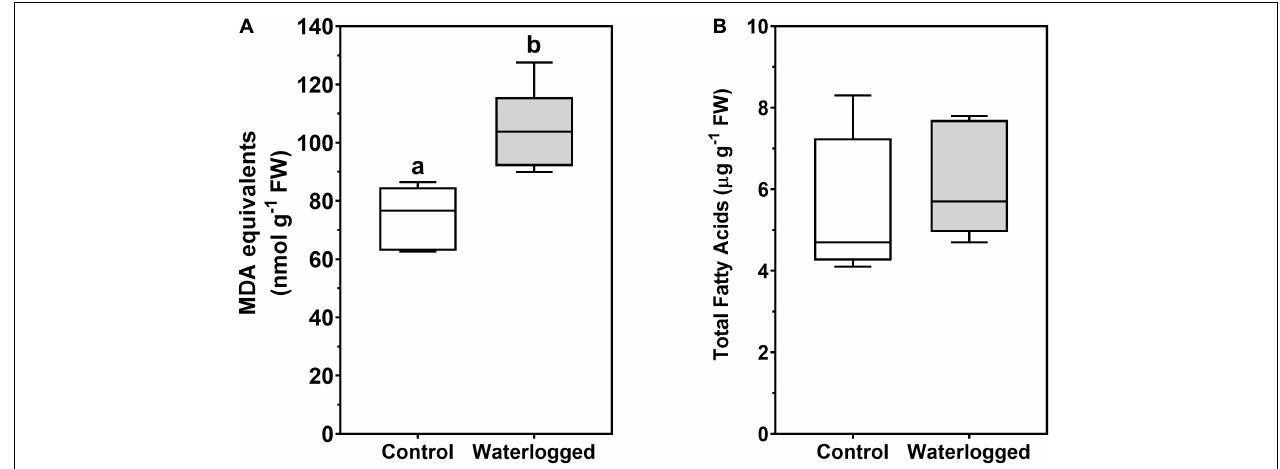
FIGURE 11 | Boxplots of lipid peroxidation quantification measured as malondialdehyde (MDA) equivalents (A) and total fatty acid content (B) in leaves of control plants (white boxes) and waterlogged plants (gray boxes) of Spartina patens after 30 days ( n = 5, different letters indicate significant differences at p < 0.05).